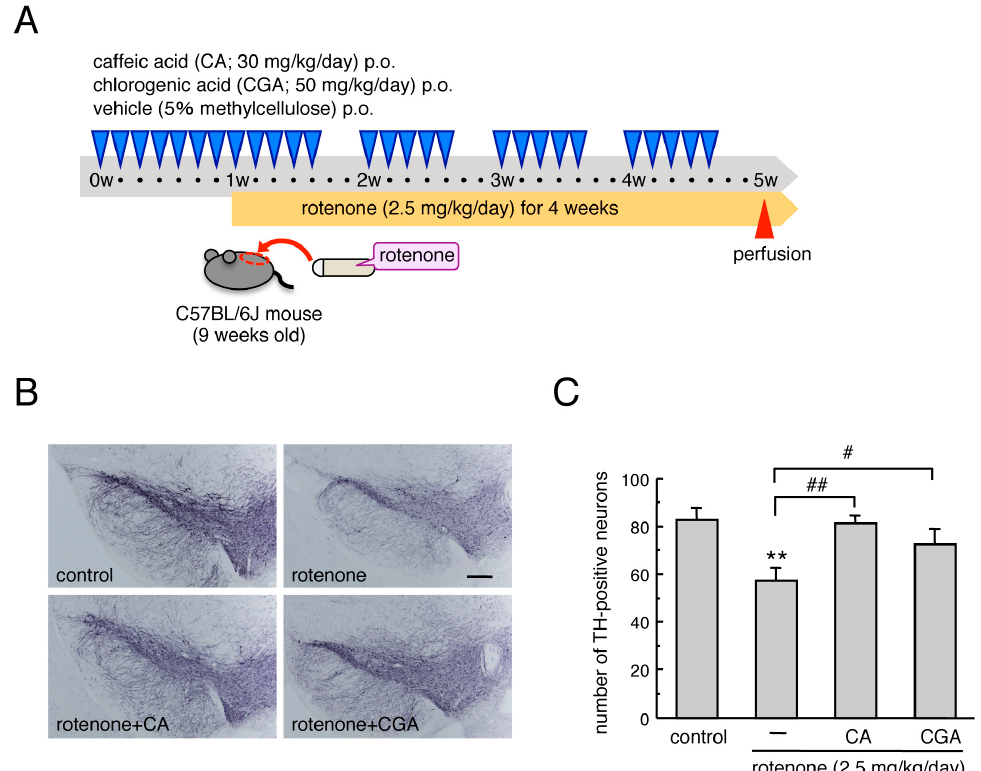
Figure 1. Administrations of CA or CGA prevented degeneration of dopaminergic neurons in the SNpc of rotenone-treated mice. ( A ) Schematic illustration of the experimental protocol. Male C57BL/6J mice were injected subcutaneously with rotenone (2.5 mg/kg/day) for four weeks using an osmotic mini pump. Mice were orally administered CA (30 mg/kg/day) or CGA (50 mg/kg/day), dissolved in 5% methylcellulose, daily for one week before rotenone exposure, and then 5 days/week during the four weeks of rotenone treatment. ( B ) Representative photomicrographs of immunohistochemistry for TH in the SNpc of rotenone-treated mice after treatment with CA or CGA. Scale bar = 200 µ m. ( C ) Changes in the number of TH-positive nigral neurons after administration of CA or CGA. Each value is the mean ± SEM (n = 6–7). ** p < 0.01 vs. the vehicle-treated control group, # p < 0.05, ## p < 0.01 between the two indicated groups.